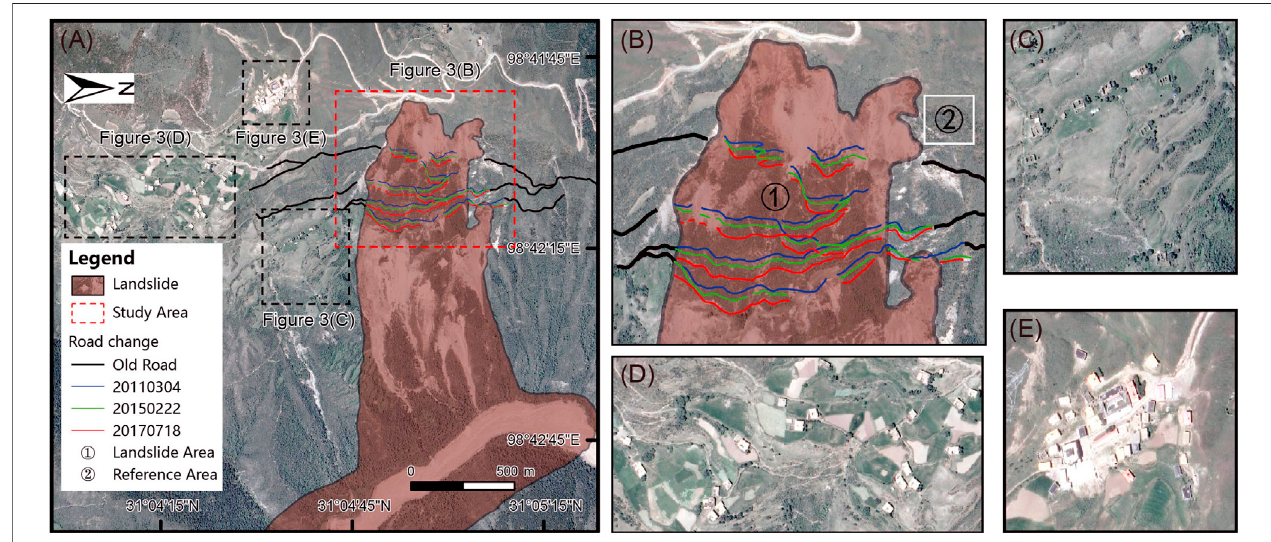
FIGURE 3 | The Baige landslide (A) Interpretation map of Baige landslide (modi fi ed from State Key Laboratory of Geohazard Prevention and Geoenvironment Protection, 2018 (http://www.sklgp.cdut.edu.cn/info/1018/2247.htm)) (B) Deformation map of the road (C) Community-1 (D) Community-2 (E) Community-3.